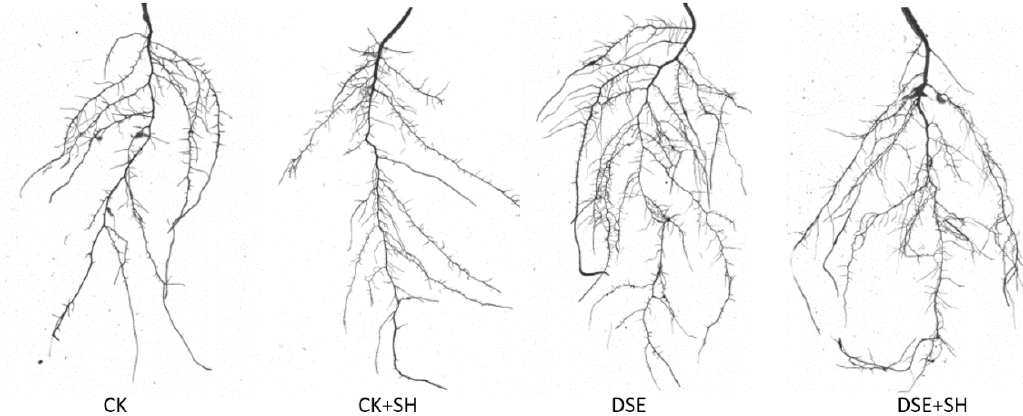
Figure 2. Different inoculation impacts on the root structures of seedlings of CK, CK + SH, DSE,